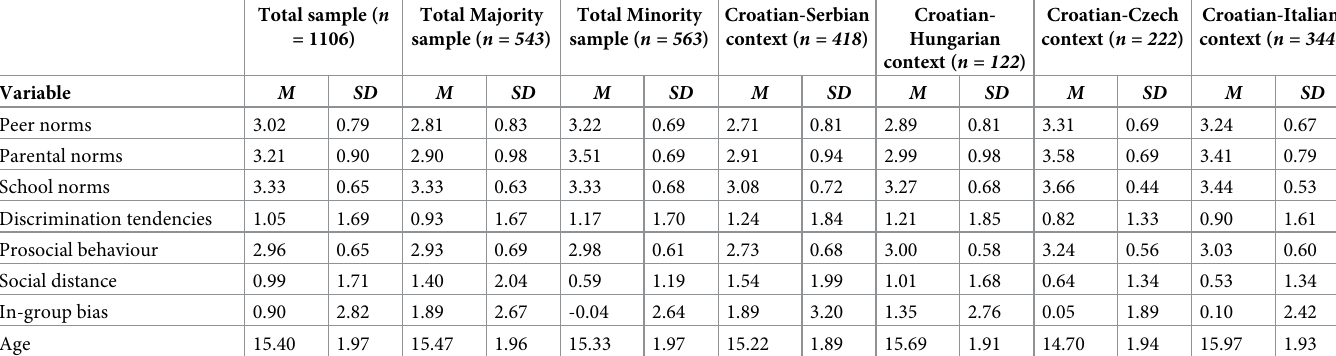
Table 2. Means and standard deviations of main study variables for total sample and per status and contextual